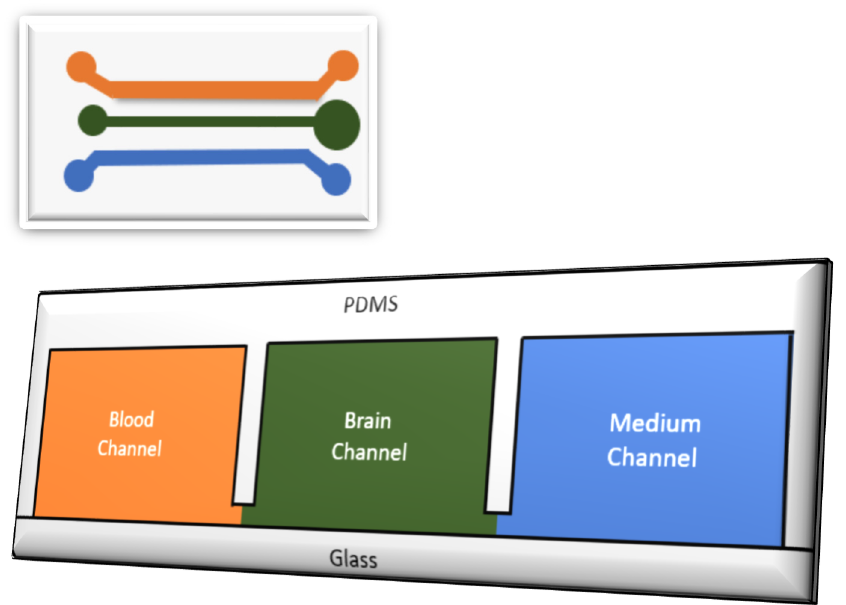
Figure 6. Top-down schematic of a typical microfluidic model with separated channels (approxi- mately 2 cm in length. Bottom organ-on-chip model of BBB. Note each channel has microchannel separators marked by the colour interface of each channel (approximately 3 μ m wide between blood and brain, and 50 μ m between medium and brain)).